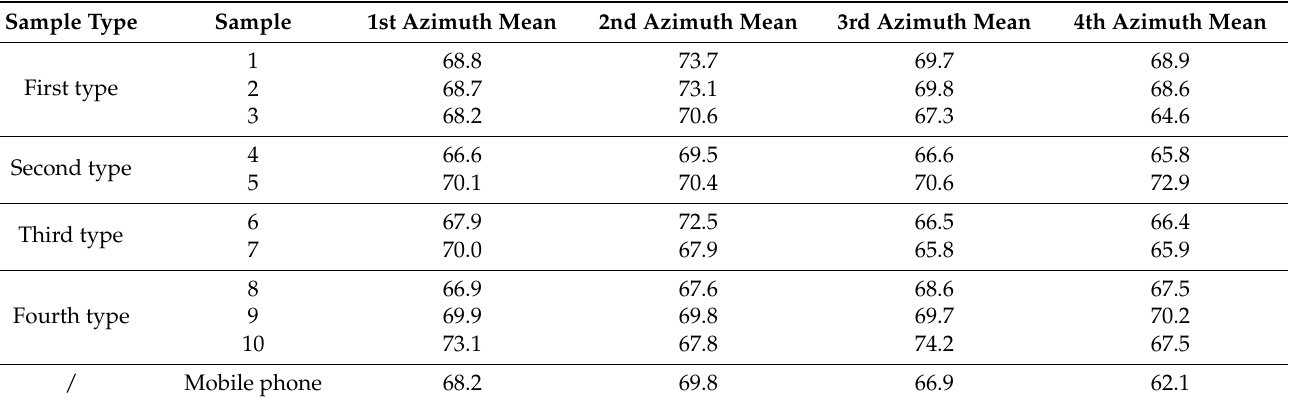
Table 7. Average values of A-weighted equivalent continuous sound pressure level for 4 azimuths of 10 samples (dbSPL).